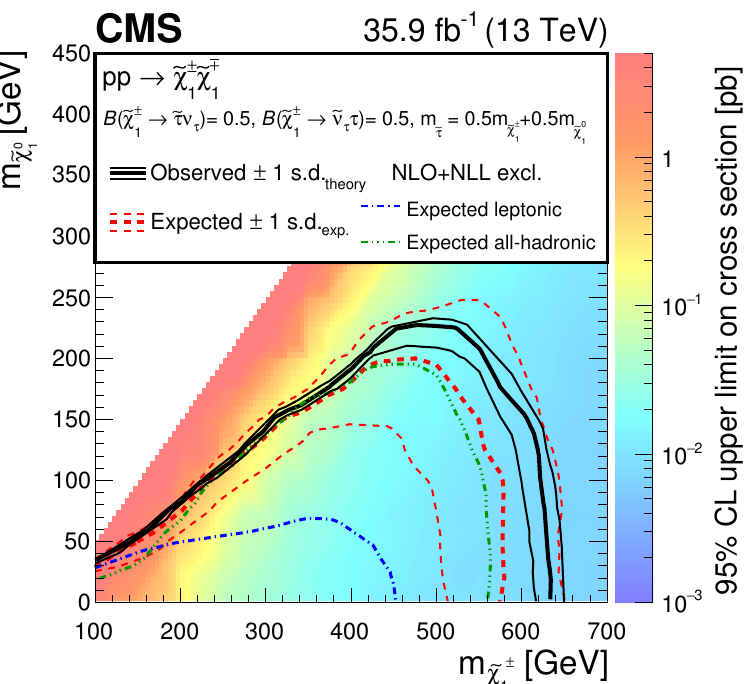
Figure 15. Exclusion limits at 95% CL for chargino pair production with decays through (cid:12)nal states with (cid:28) leptons. The production cross sections are computed at NLO+NLL precision assuming a wino-like (cid:31) (cid:6) , light bino (cid:31) 0 , and with all the other sparticles assumed to be heavy and 1 1 decoupled [72, 73]. The regions enclosed by the thick black curves represent the observed exclusion at 95% CL, while the thick dashed red line indicates the expected exclusion at 95% CL. The thin e e black lines show the e(cid:11)ect of variations of the signal cross sections within theoretical uncertainties on the observed exclusion. The thin red dashed lines indicate the region containing 68% of the distribution of limits expected under the background-only hypothesis. The green and blue dashed lines show separately the expected exclusion regions for the analyses in the all-hadronic and leptonic (cid:12)nal states,